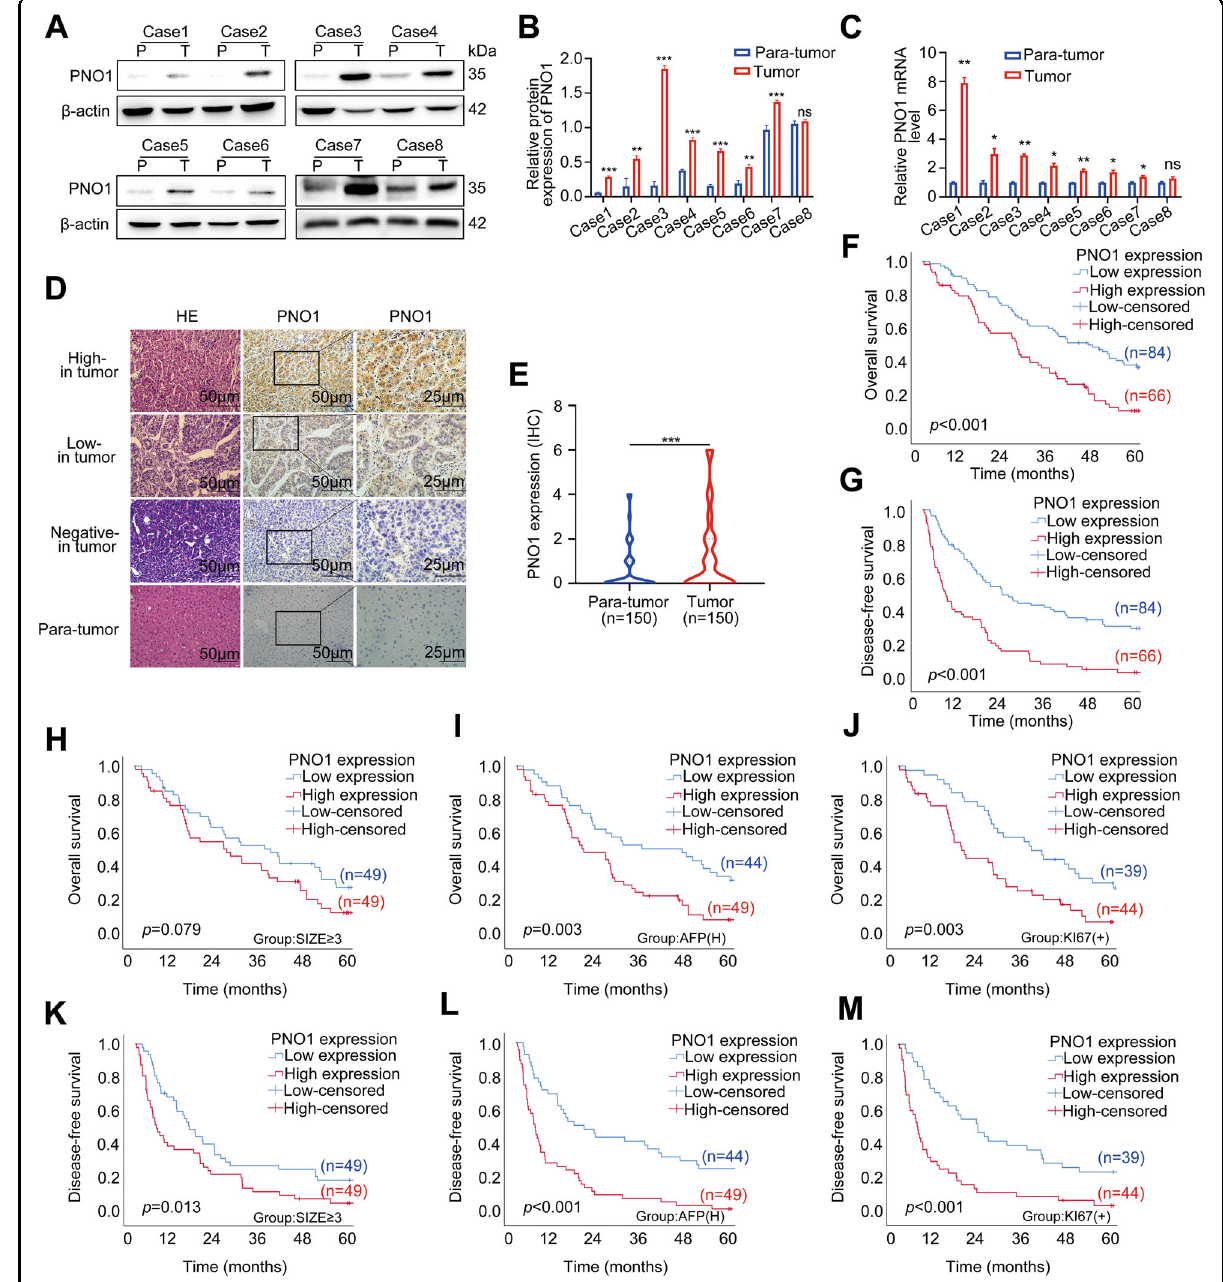
Fig. 1 PNO1 expression is elevated in HCC tissue samples and predicts poor survival in HCC patients. A – C Western Blotting and RT-PCR showing the differences in the PNO1 protein and mRNA levels between eight pairs of HCC tissue (T) and adjacent normal tissue (P). D , E IHC analysis of PNO1 expression in 150 pairs tissue microarrays of HCC specimens. Representative images were taken at a magni fi cation of 50 or 25 μ m, p < 0.05. F , G The Kaplan – Meier survival analysis of overall survival ( F ) and disease-free survival ( G ) for 150 HCC patients. H , K The Kaplan – Meier survival analysis of overall survival ( H ) and disease-free survival ( K ) for HCC patients in tumor size ≥ 3 cm subgroup. I , L The Kaplan – Meier survival analysis of overall survival ( I ) and disease-free survival ( L ) for HCC patients in high serum AFP level subgroup. J , M The Kaplan – Meier survival analysis of overall survival ( J ) and disease-free survival ( M ) for HCC patients in a more positive rate of Ki-67 subgroup. Data were presented as mean ± SEM. n = 3 – 4. * p < 0.05, ** p < 0.01, *** p <